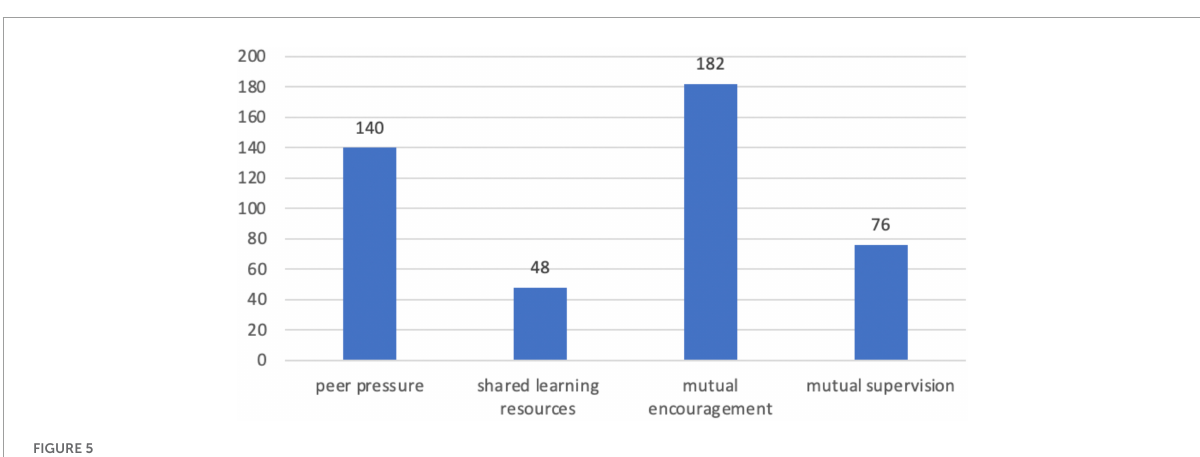
FIGURE5 Affordances of the